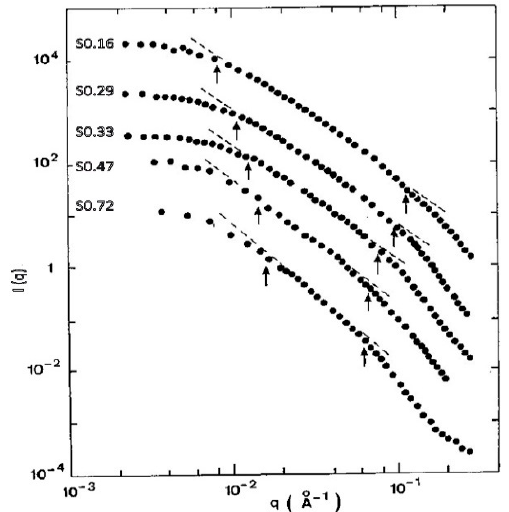
Figure 9. I(q) as measured by USAXS for the N18 sintered aerogels (from [53]).